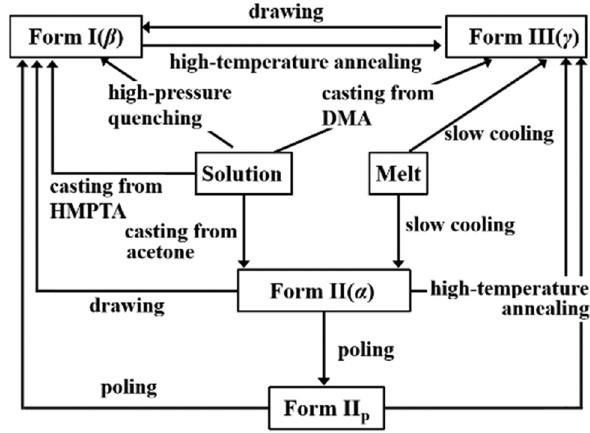
Figure 4: Transformation among various phases of PVDF [ 25 ] .